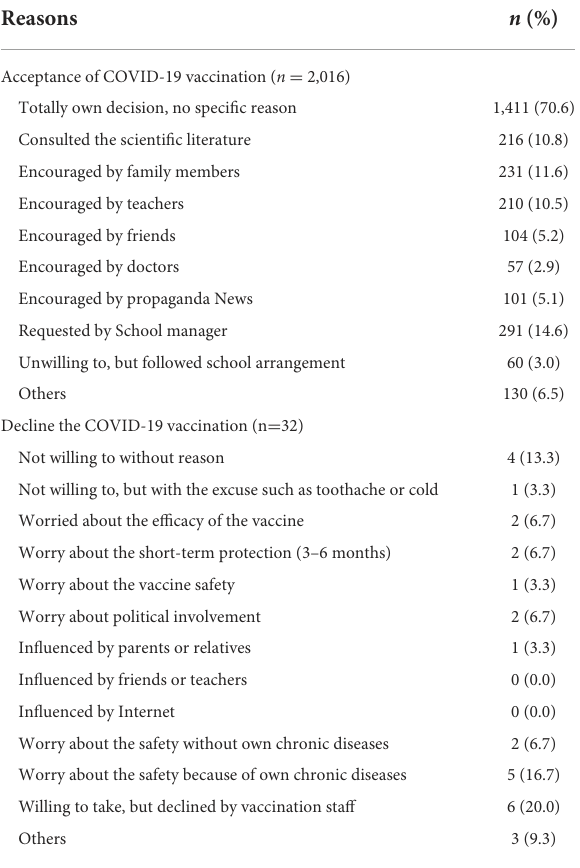
TABLE 4 Reasons for acceptance or decline of COVID-19 vaccination in participants.